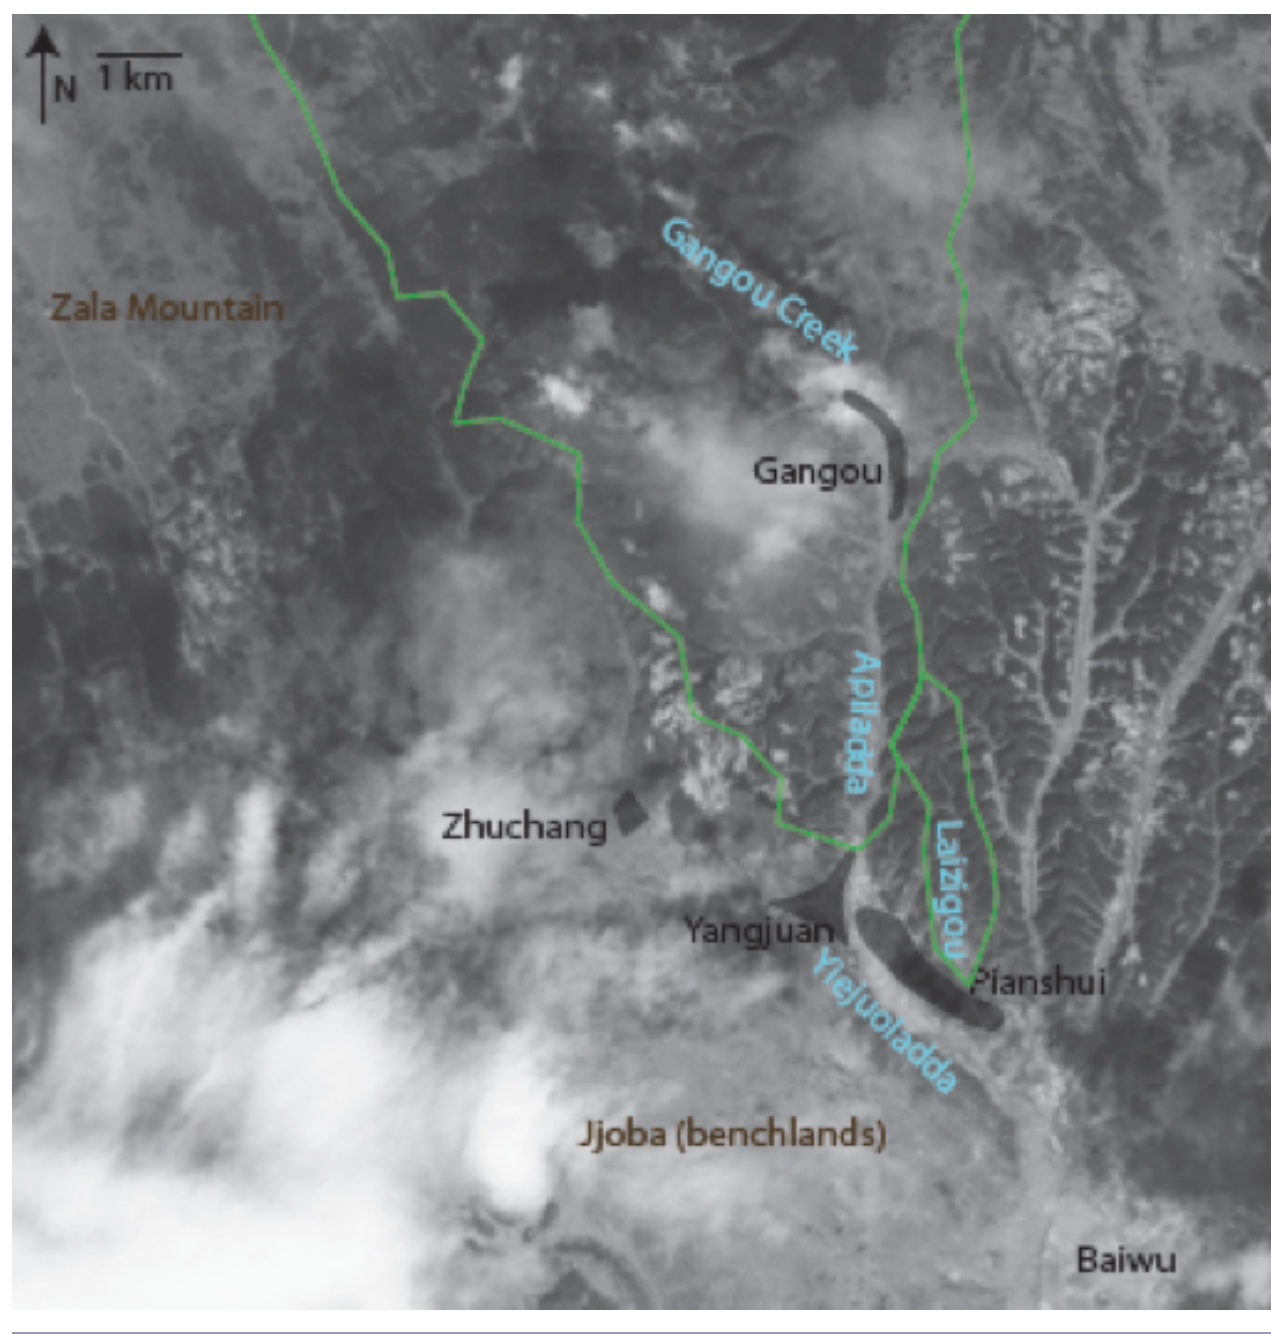
Fig. 2. The Upper Baiwu watershed, 2001 ASTER satellite image. Watershed boundaries are shown in green; watershed names are in bright blue; extent of village housing is in gray shading; village names are in black; geographic locations referred to in the text are in